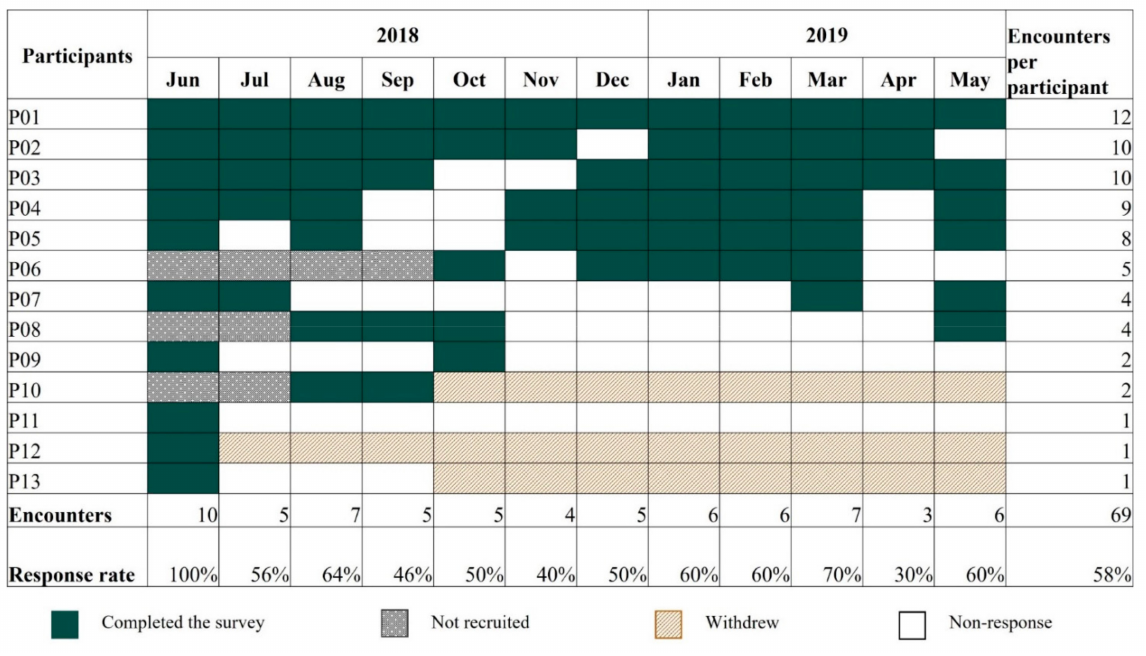
Figure A1. Summary of recruitment and response rates by participant and by